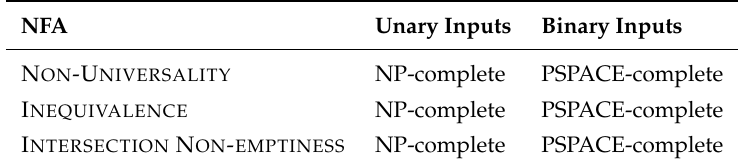
Table 3. The classical complexity status of three types of problems on nondeterministic finite automata.